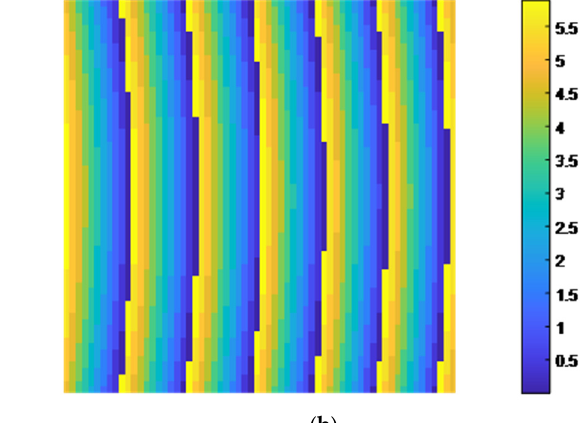
Figure 1. Radiation direction diagram of the RIS unit.